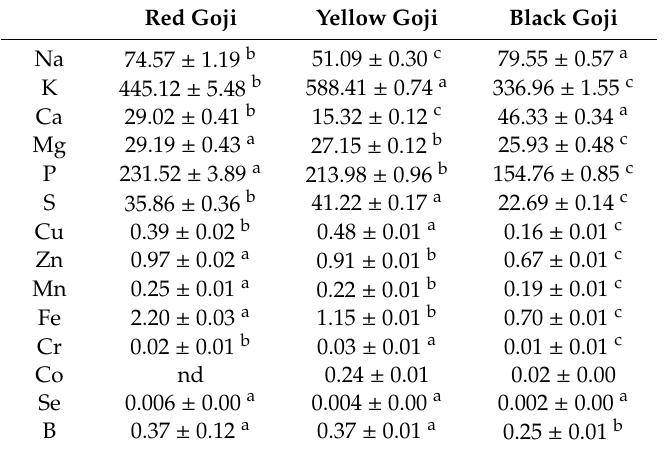
Table 3. Results of mineral analysis of goji berry fruits, mg / 100 g FW (mean ± SD; n = 3).